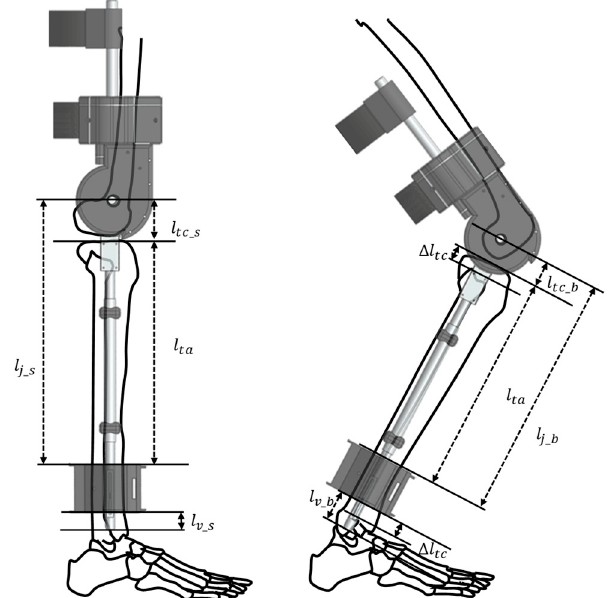
Figure 6. Description how the self-alignment structure solves the problem caused by the change of the LBKA. The length of lower frame decreased by ∆ l tc , so the exoskeleton coincides with the knee axis of the wearer.